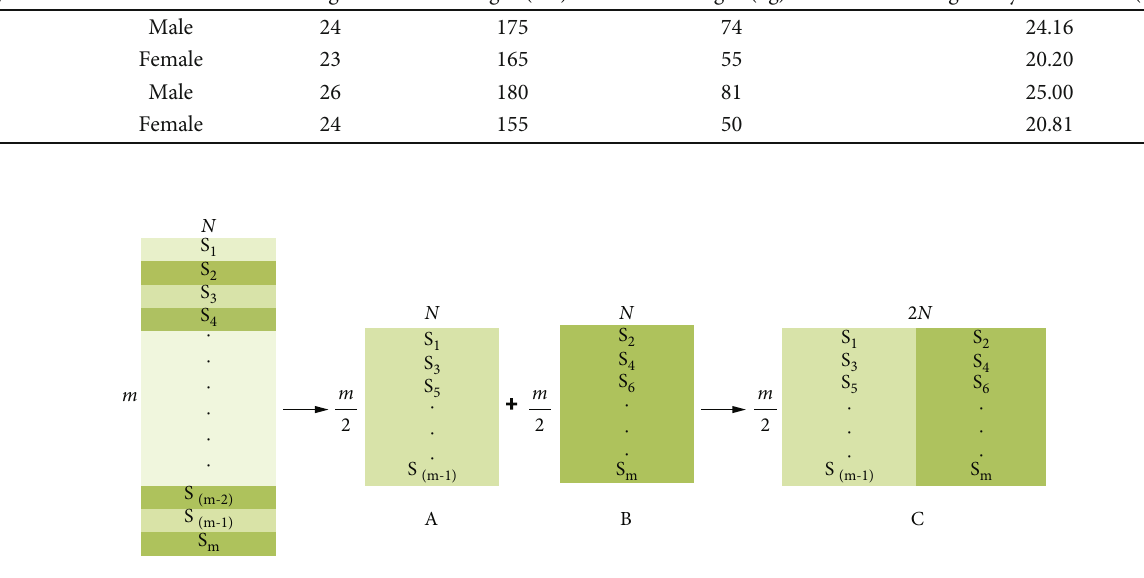
Figure 3: The operation of the MSFS method. Table 3: Pearson correlation coe ffi